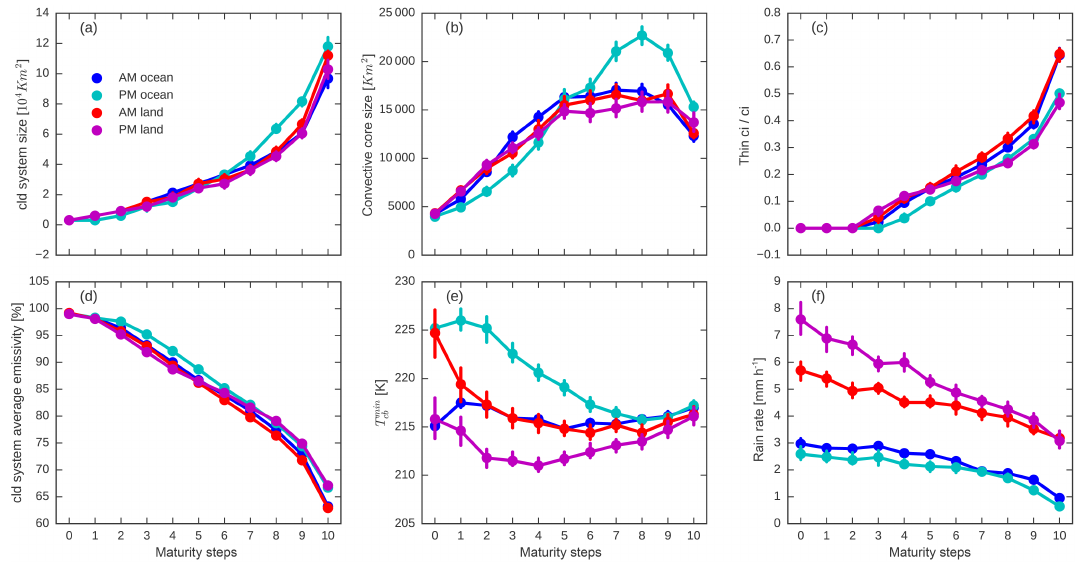
Figure 9. Median values and standard errors of physical properties of single-core convective systems for the 11 maturity steps defined by fraction of convective area (1, 0.78, 0.65, 0.55, 0.47, 0.40, 0.34, 0.29, 0.24, 0.19, 0.13, 0.01) separately over the ocean and over land, and during the night (AM) and early afternoon (PM): (a) cloud system size, (b) convective core size, (c) thin cirrus over cirrus area, (d) cloud system average emissivity, (e) minimum temperature within convective core, (f) average convective core rain rate. Panels (a–e) display AIRS data, 2003–2015; (f) AIRS and AMSR-E data, 2003–2009.